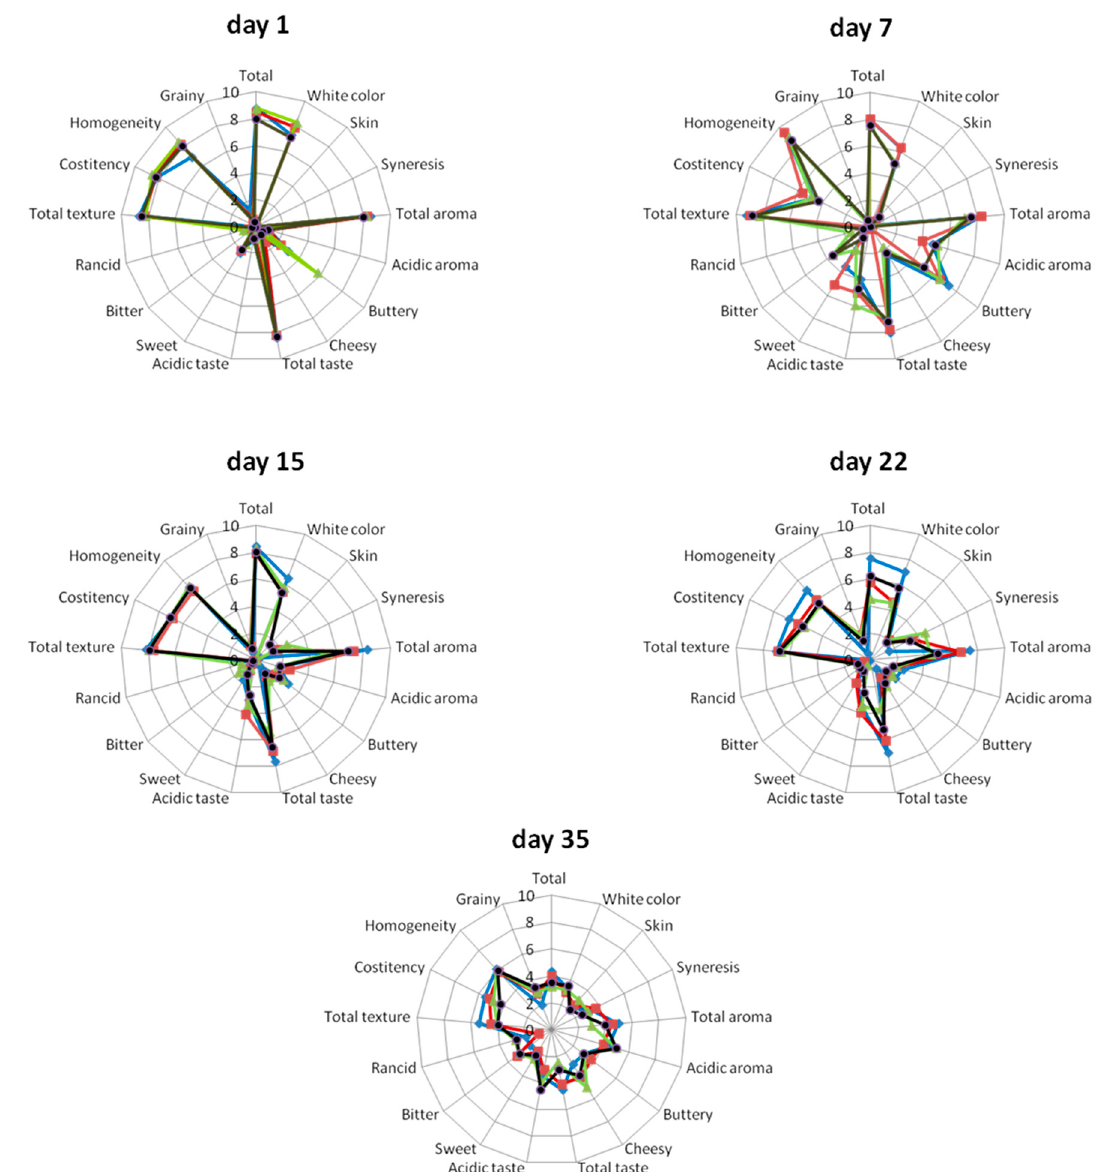
Figure 5. Sensory evaluation of yogurts during refrigerated storage at 4 °C (sampling day 1, 7, 15, 22, and 35). (